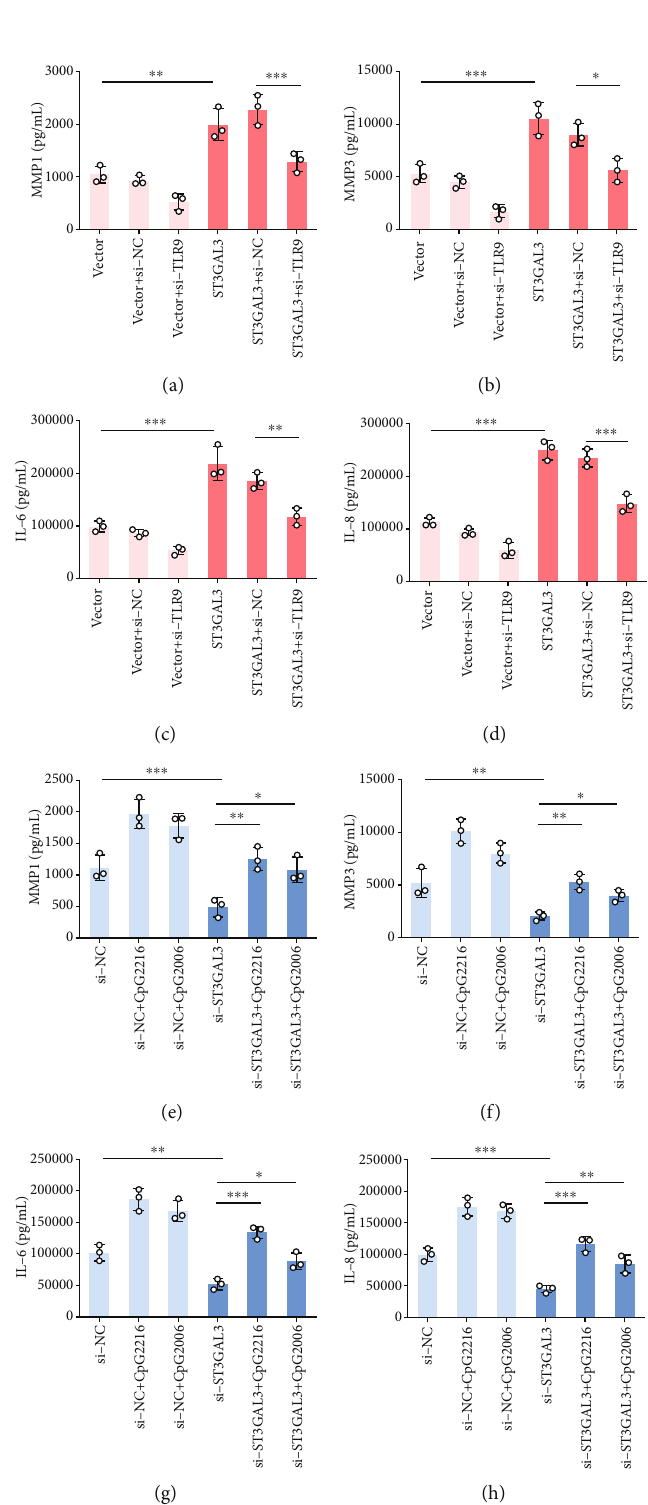
Figure 7: ST3GAL3 promoted the in fl ammatory response of MH7A cells by activating the TLR9/MyD88 pathway. (a – d) ELISA results showed that transfection of MH7A cells with si-TLR9 reversed the e ff ects of ST3GAL3 on MMP1, MMP3, IL-6, and IL-8 levels. (e – h) ELISA results showed that adding with CpG-ODNs reversed the e ff ects of si-ST3GAL3 on MMP1, MMP3, IL-6, and IL-8 levels. n = 3 . ∗ p < 0 : 05 , ∗ p < 0 : 01 , and ∗∗∗ p < 0 : 001 compared with the indicated